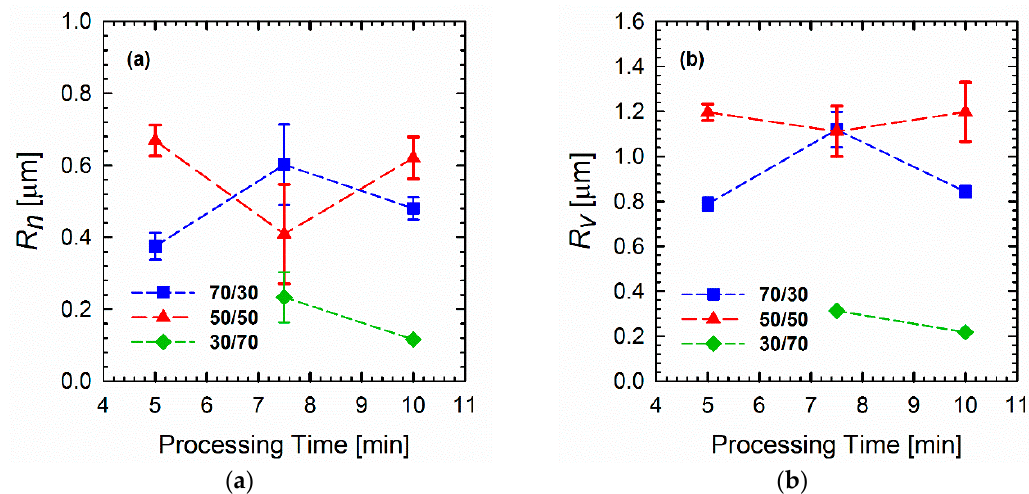
Figure 3. ( a ) Number average ( R n ) and ( b ) volume average ( R v ) radii sizes of droplets in blends of various compositions calculated based on Equations (5) and (6) from SEM images. The 30/70 PLA/PVDF blend processed for 5 min did not show a distinct droplet morphology, and, hence, the calculations for this composition were done after processing for 7.5 and 10 min only.